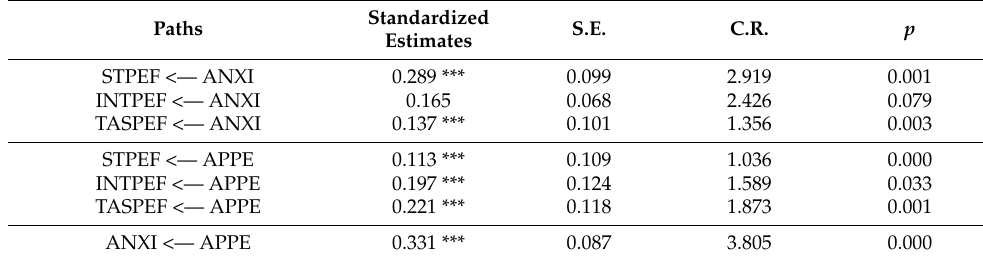
Table 6. Path estimates of SEM.